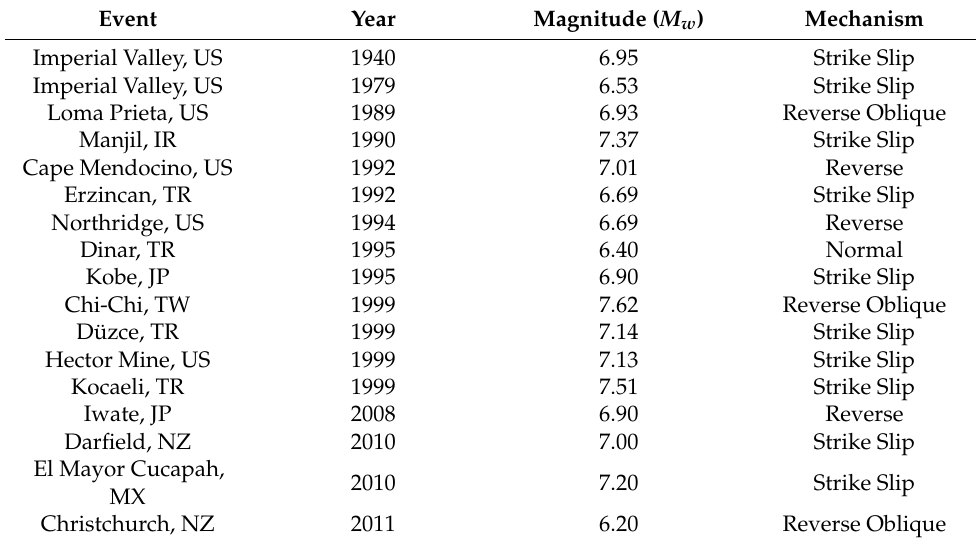
Table 7. Earthquake events considered in the analysis.